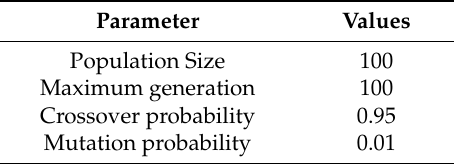
Table 1. The parameter setting of the genetic algorithm.